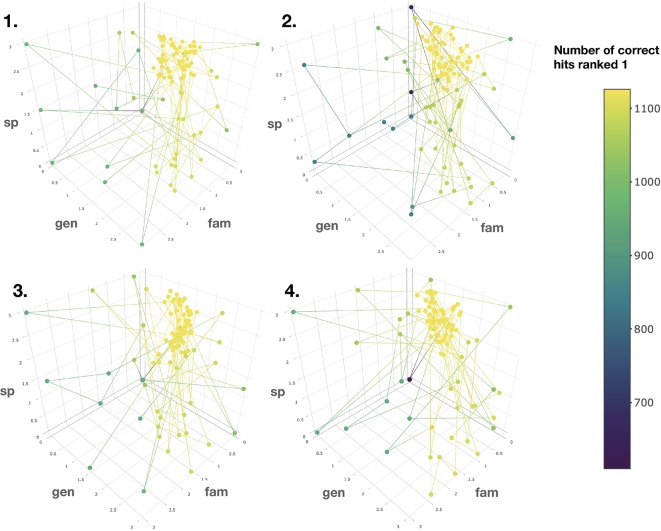
Results of the Bayesian optimization converge toward the optimal scores combination required for a maximal number of correct annotations ranked at the first position. This is observed for four randomly degraded training sets (first optimization round displayed). sp, gen and fam axes correspond to the score given when a match is found at the species, genus or family taxa level, respectively. Results confirm that the applied scores should be inversely proportional to the taxonomic distance between the biological source associated with the queried spectra and the biological source of the candidate structures.